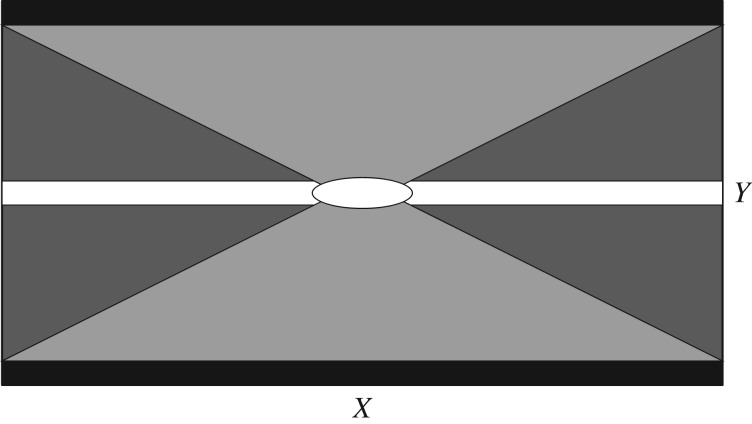
A schematic showing the different regions on a vector feature map associated with different wavefront dynamics. The oval region at the centre corresponds to electrograms recorded near the AF driver—wavefronts in this region spread in all directions. The white strips either side of the centre indicate convex wavefronts which propagate along the X-axis centred on the driver. The black strips correspond to positions near the circular boundary where wavefronts propagating in the +Y and −Y directions from the driver collide. Finally, the grey regions represent the ‘bulk’, usually crossed by wavefronts that are approximately planar. The dark grey regions correspond to tissue which statistically only observes unidirectional flow in X, i.e. all electrograms in the dark grey region on the left only observe wavefronts propagating from the right. The light grey regions represent positions relative to the ectopic beat which can statistically observe bidirectional flow in X, i.e. positions in the light grey regions could see wavefronts approaching from either +X or −X over various tissue instances. The transition between these regions is not always sharp and varies over tissue instances. Note that not all vector feature maps are sensitive to all the different wavefront dynamics shown here.